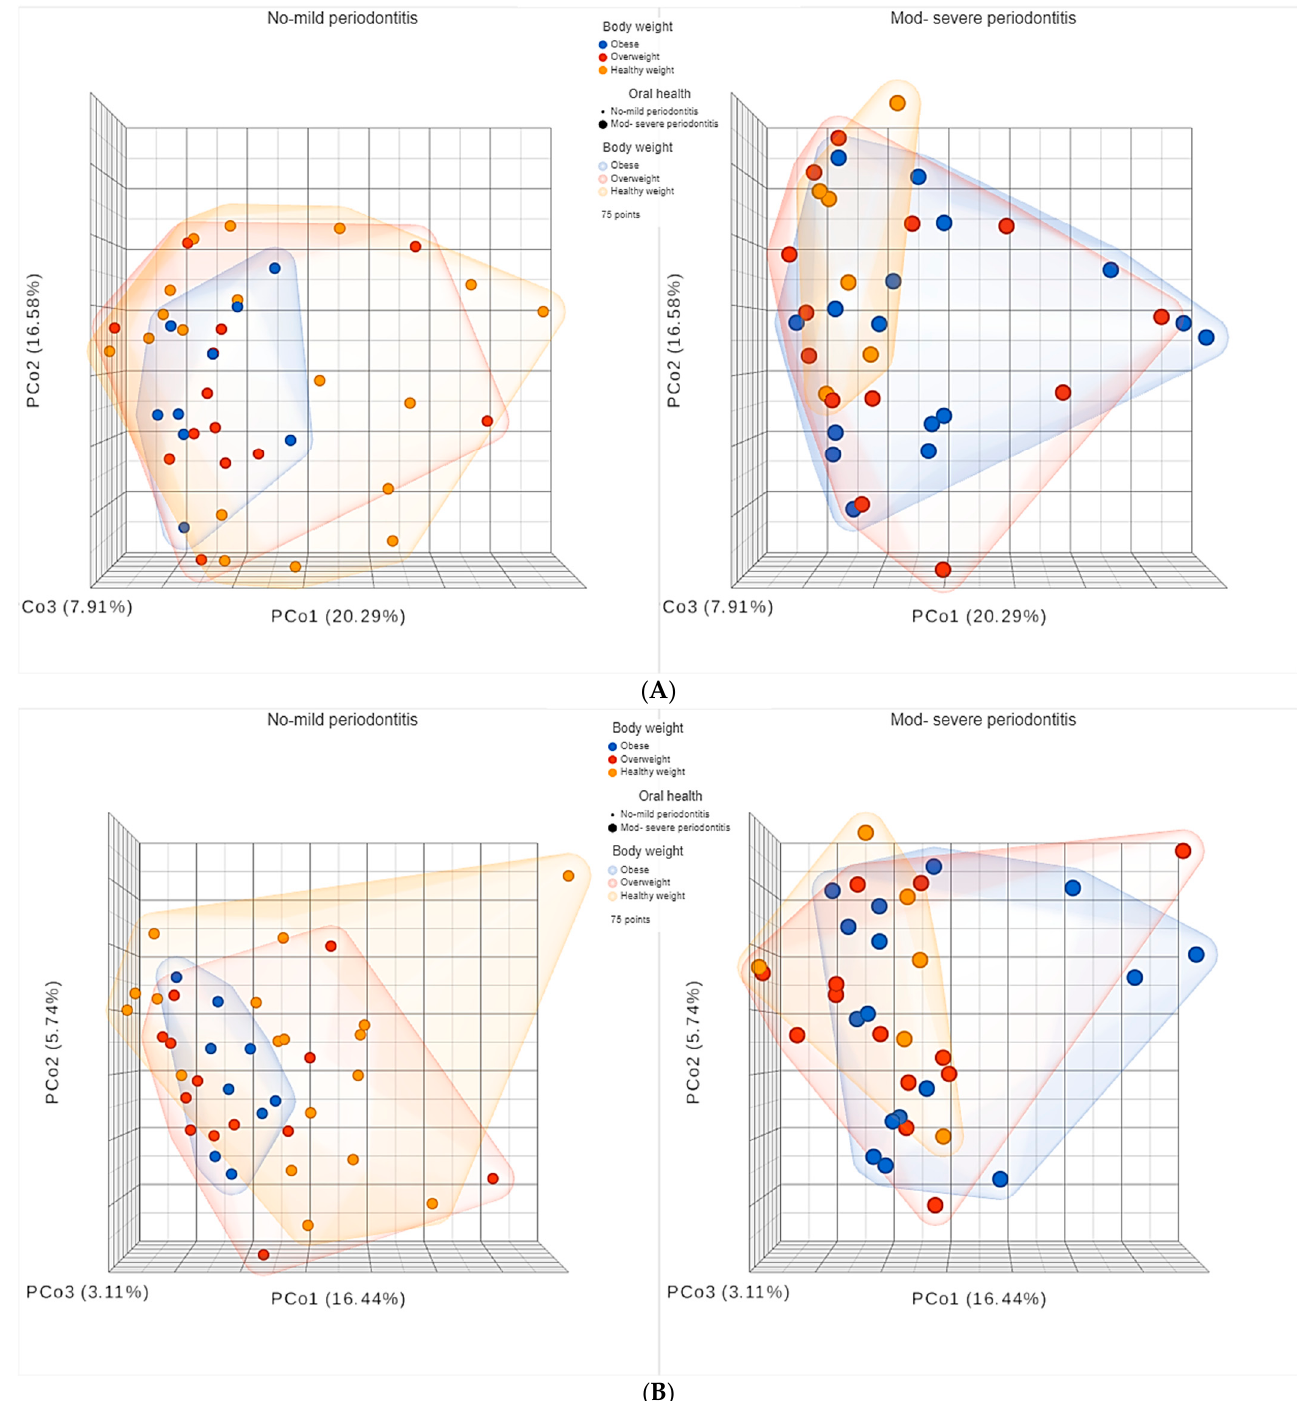
Figure 11. Principal coordinates (PCo) analysis plots of beta diversity indices ( A ) Bray Curtis and ( B ) Jaccard. Participants were grouped based periodontal heath status, then sub-grouped based on BMI.